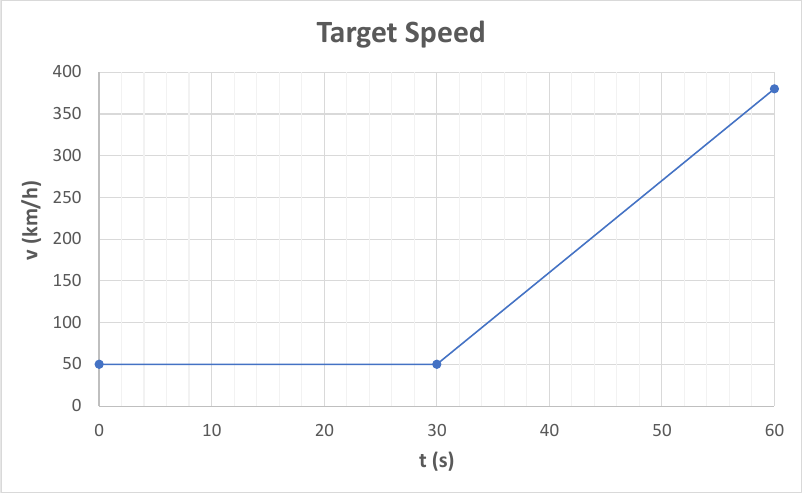
Figure 17. Speed profile imposed for the calibration of the model, for the simulation of the hypercar.